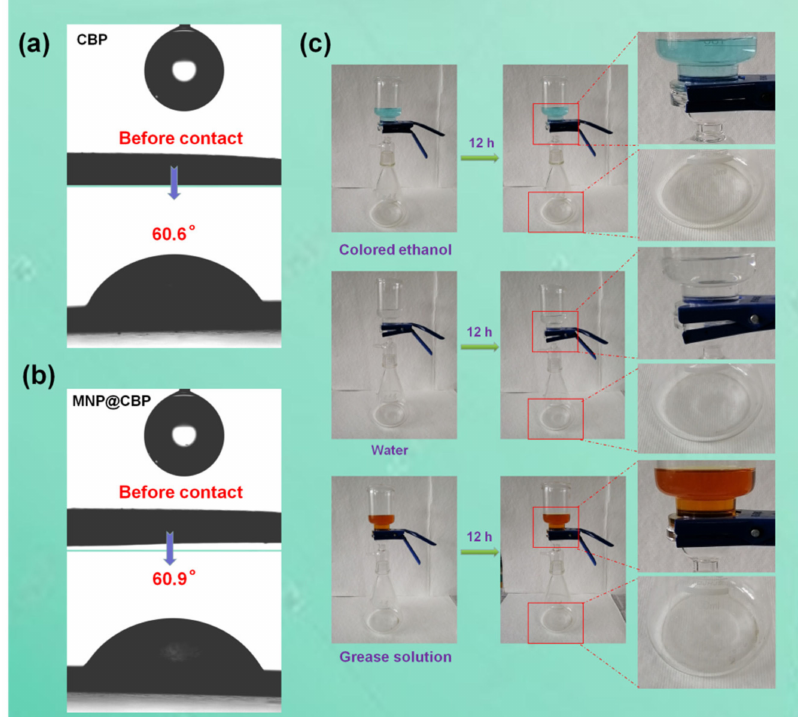
Figure 13. ( a , b ) Water contact angle images of the CBP and MNP@CBP3, ( c ) interaction between MNP@CBP3 and water, colored ethanol and grease solution (mixture of castor oil, toluene, and n -heptane, with volume percentages of 30%, 35%, and 35%, respectively).